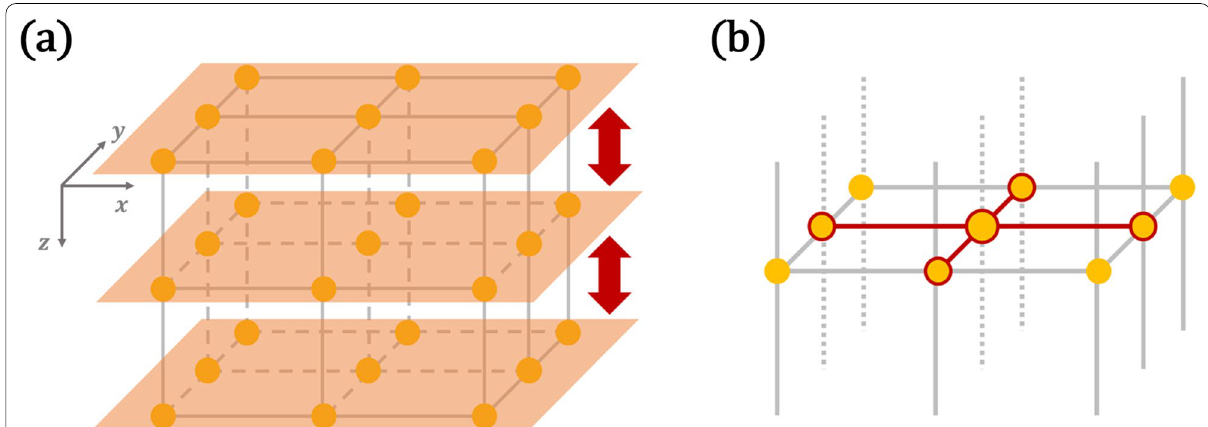
Fig. 1 Schematic diagrams of the penalty terms used in the proposed method. a Vertical-direction penalty. The sum of the second-order velocity differences among adjacent layers of depth is penalized. b Horizontal-direction penalty. The first-order velocity differences among adjacent grid points on the same layer are penalized. The central grid point in this figure has four adjacent grid